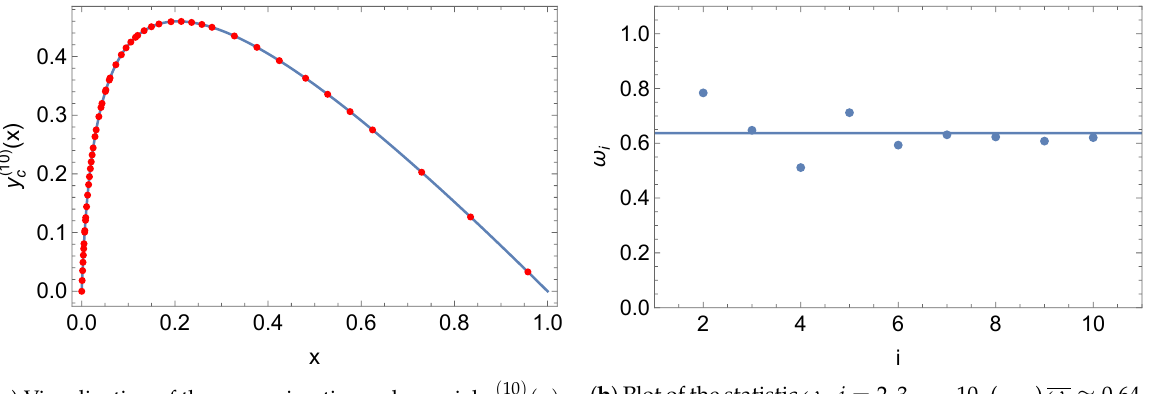
( b ) Plot of the statistic ω i , i = 2,3, . . . ,10. ( ) ω i ≈ 0.64. ( 10 ) ( x ) . A proper subset of the set of points S is shown. c